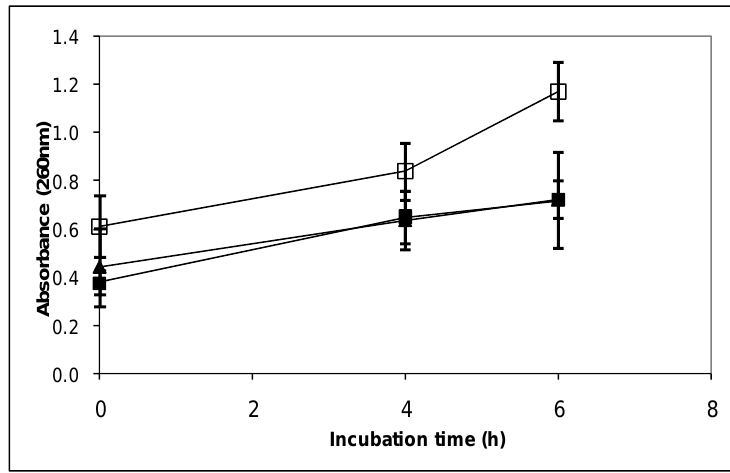
Figure 5 . Cellular leakage of 260-nm-absorbing materials. Compounds 1 or 2 or methanol were added to cells washed with sodium phosphate buffer (5 mM, pH 7.0) and incubated at 22 ºC. At the specified times extracellular fractions were collected. Control with methanol (  ), Compound 1 (  ) or compound 2 ( (cid:0) ) at 60 μ g mL -1 . Each point represents the mean of two independent experiments ± standard deviation.